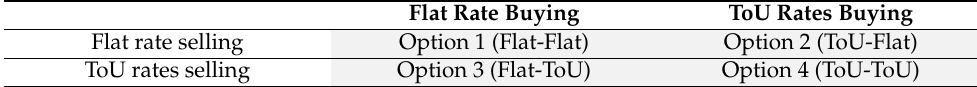
Table 3. Electricity rates for the case study in South Australia to validate the proposed EMSs [4,23]. Electricity Exchange Buying (¢/kWh) Selling (¢/kWh) Period (hr) Flat rates ToU rates during